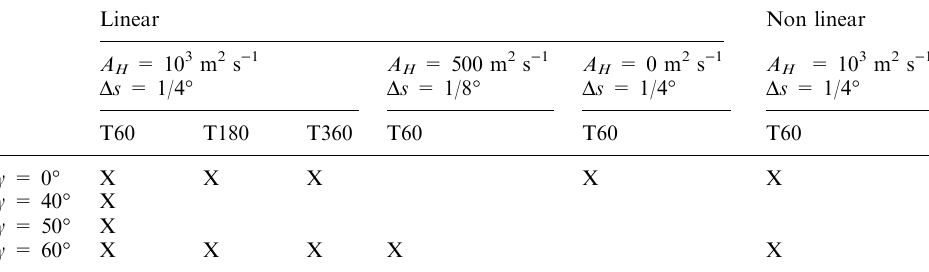
Table 1. Linear and non line- ar experiments performed for di(cid:128)erent values of coast incli- nation ( c ), wave period (T60, T180 and T360 days), dissipa- tion coe(cid:129)cient ( A H ) and grid spacing ( D s) are marked